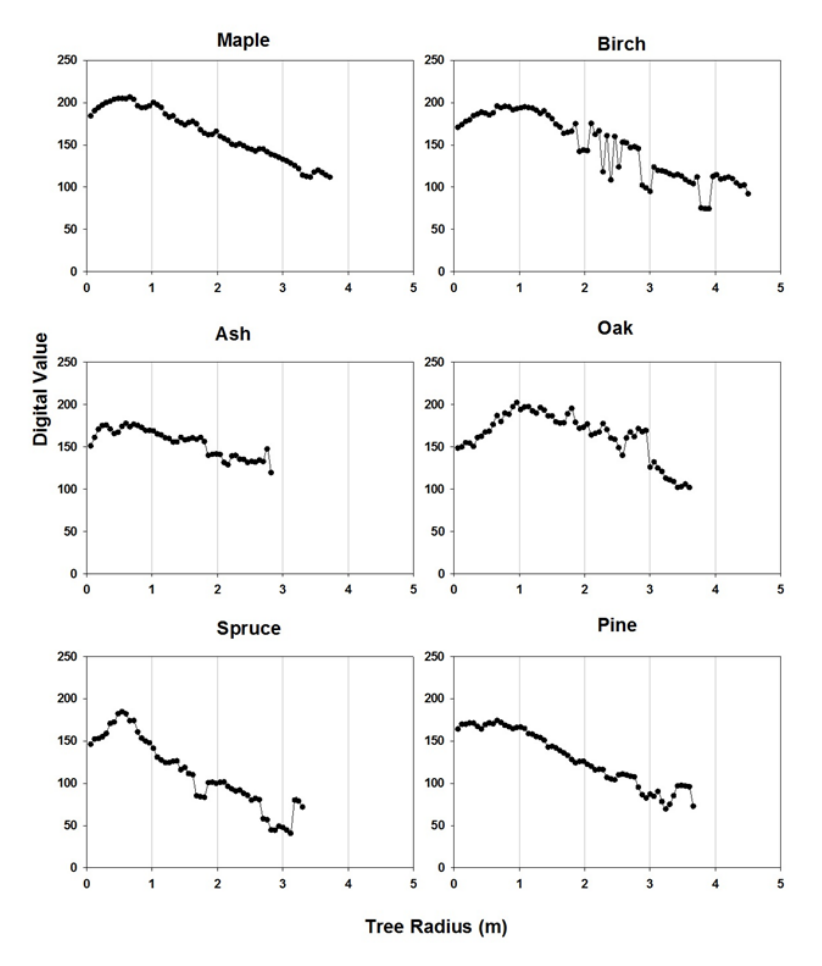
Figure 5. The longitudinal profiles of the six different